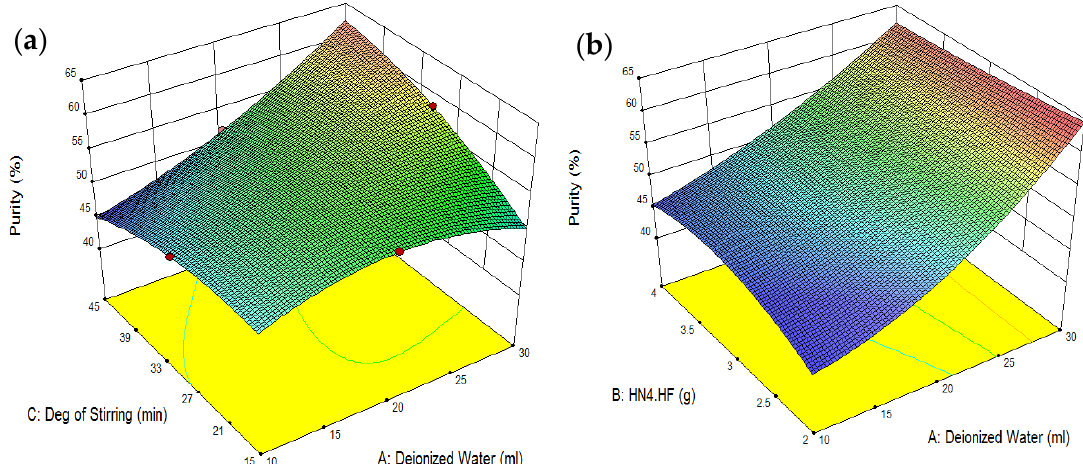
Figure 8. 3D plots of REF purity with respect to process variables at ( a ) 4 g of NH 4 F · HF and ( b ) 44 min for degree of stirring.